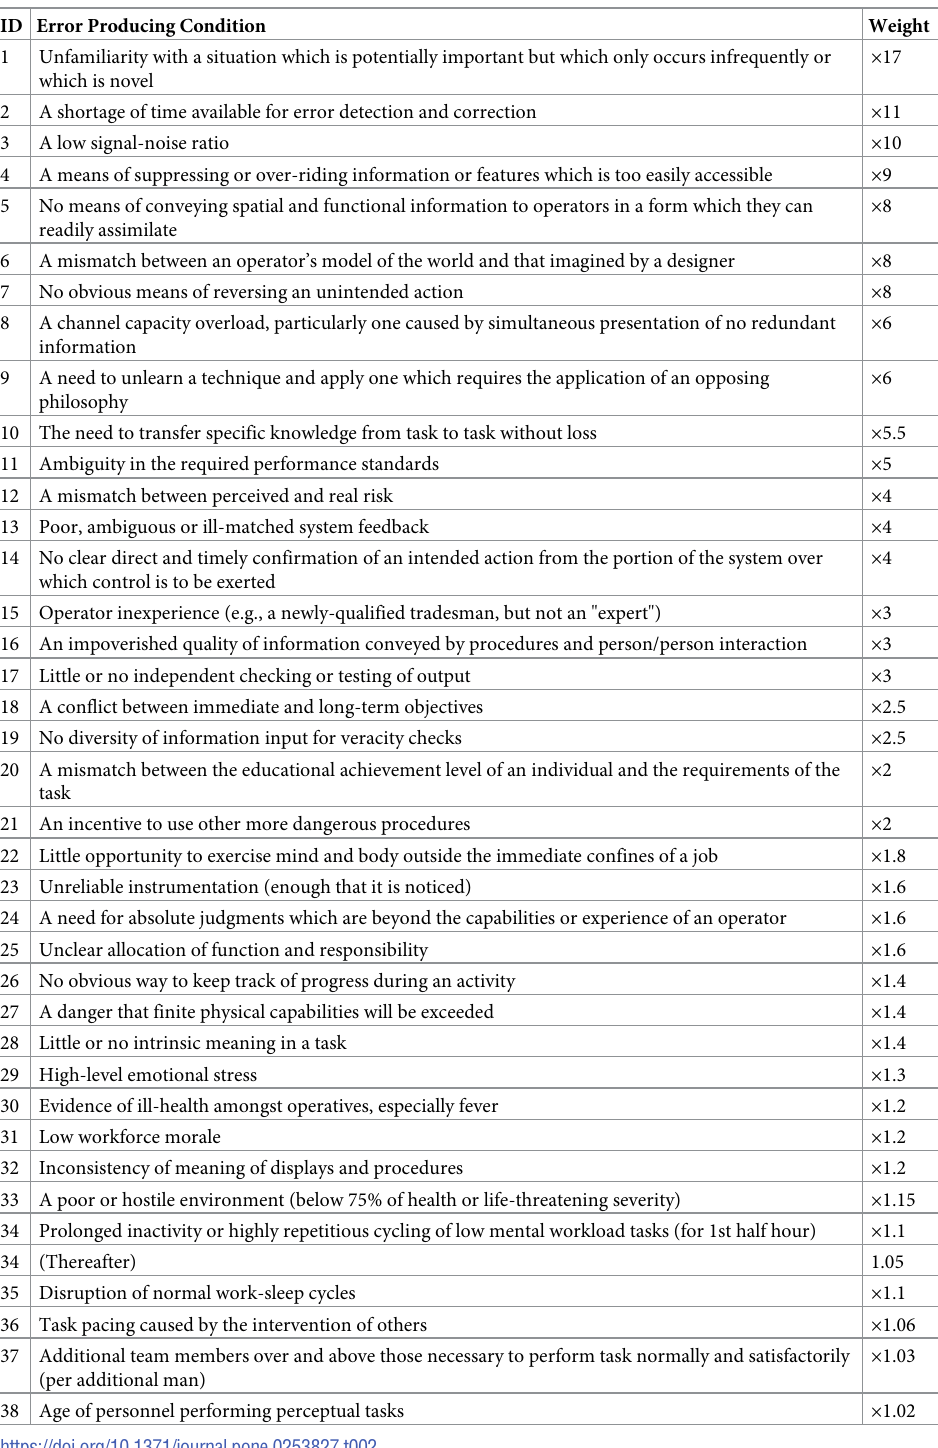
Table 2. EPC definition and related maximum